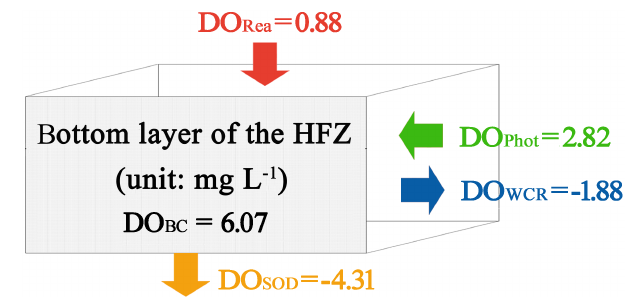
Figure 16. The simulated mass balance for the bottom DO in the HFZ. Note that positive values indicate positive effects on the DO concentrations, while negative values indicate negative effects (unit: mgL − 1 )